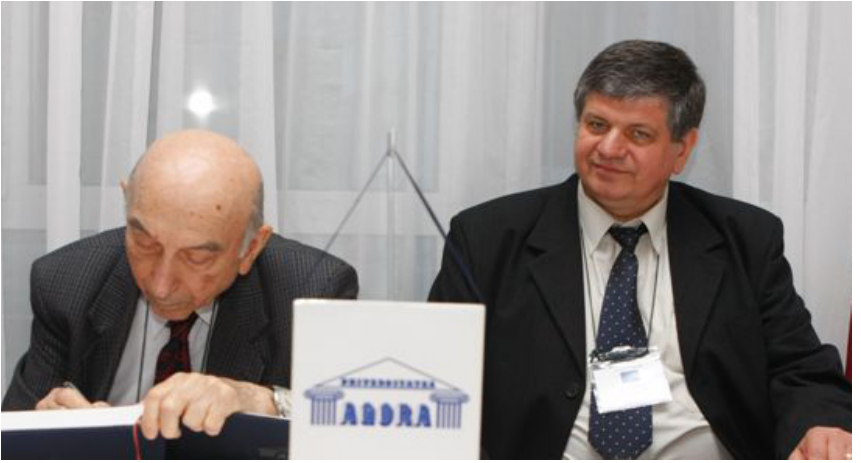
Figure 1. Ioan Dzitac and Lotfi A. Zadeh at ICCCC